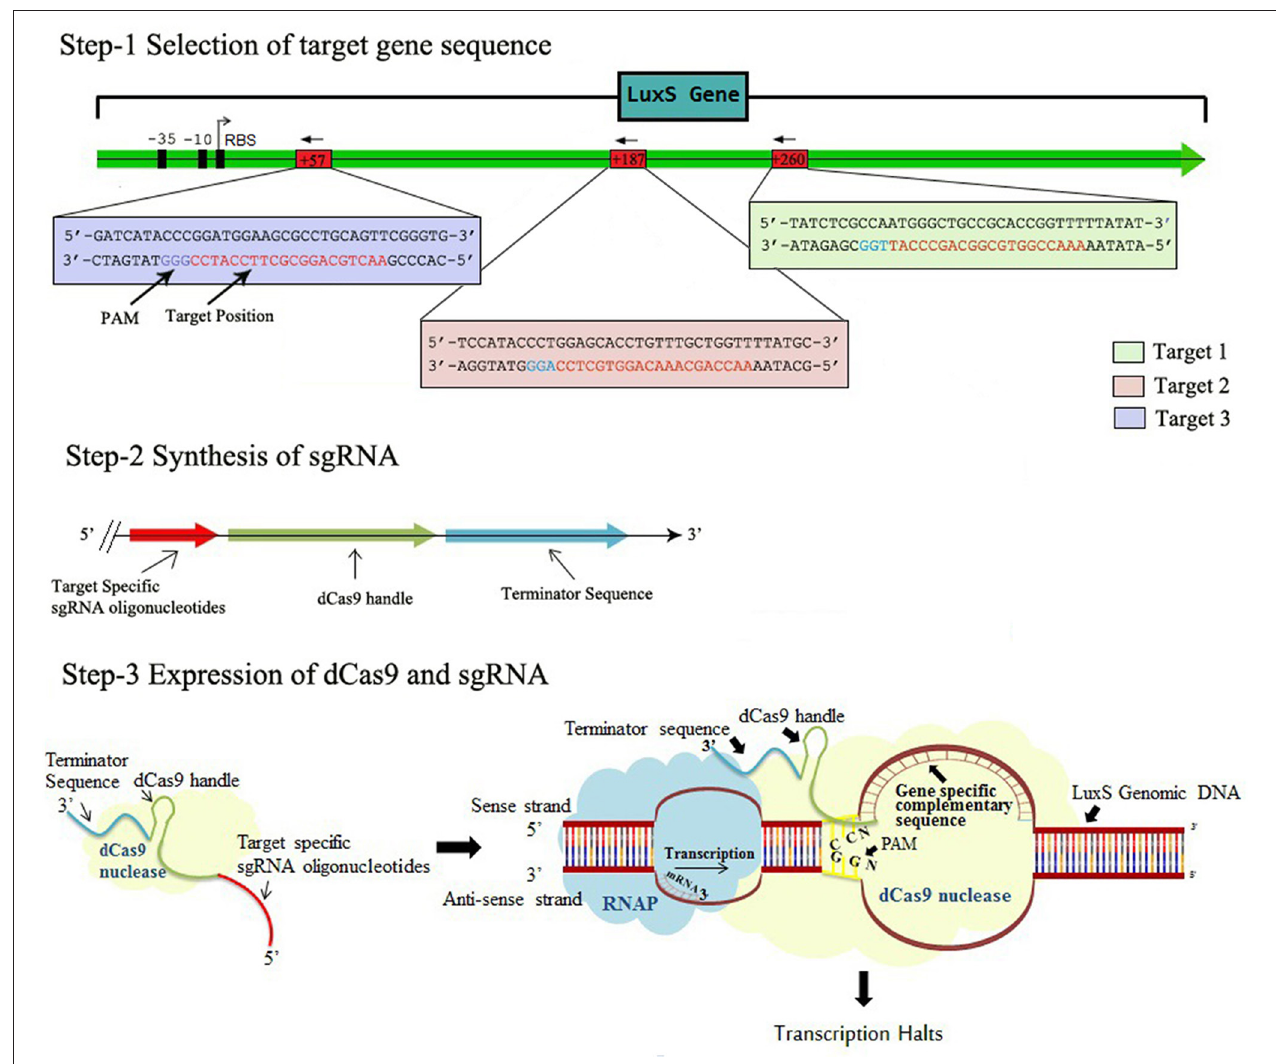
FIGURE 1 | The Schematic representation of CRISPRi mechanism, Step-1 Selection of target gene sequence based on its distance from TSS side, PAM location, GC content, off-targeting. Step-2 Synthesis of sgRNA by appending dCas9 handle and terminating sequences. Step-3 Expression of dCas9 protein and sgRNA through cloning and co-transformation that finally blocks the